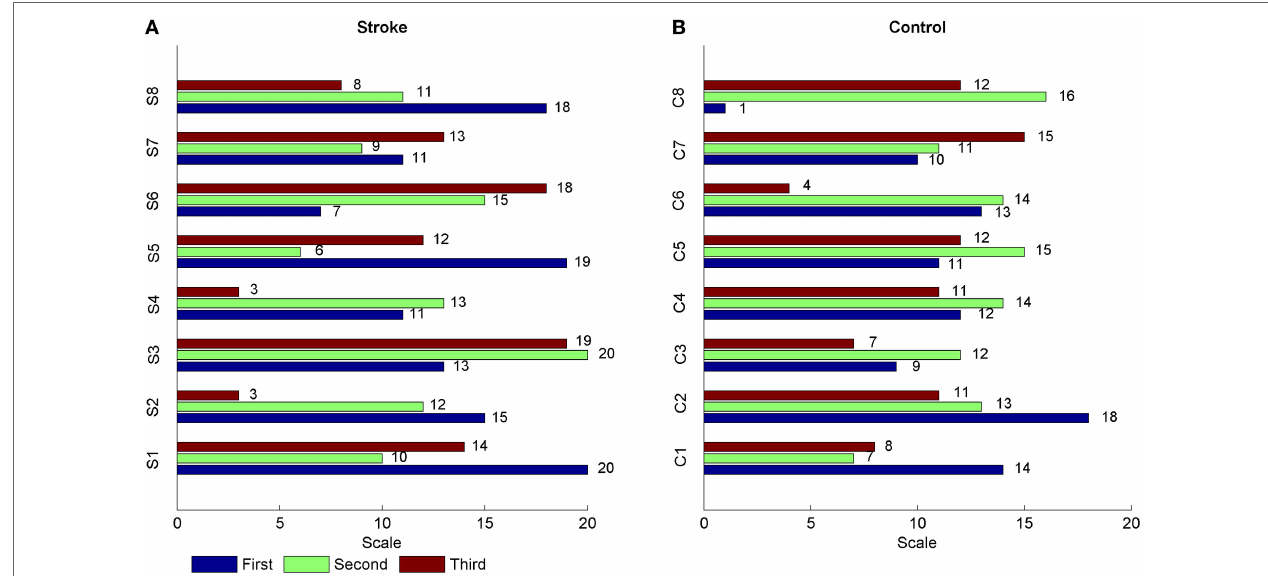
FIGURE 3 | The scales distribution where the first three higher MSTE values located for each subject. The label “S” in (A) represented the stroke patient, and the label “C” in (B) meant the healthy